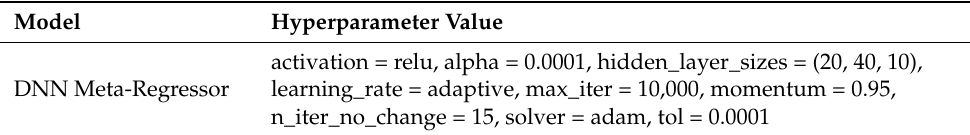
Figure 13. A schematic architecture for the meta-model to predict the viscoelastic drag coefficient using the stacking technique ensembling three optimized ML models and a meta-regressor. Table 8. Optimized hyperparameters for the DNN meta-regressor trained, validated and tested on SMOTE-set .